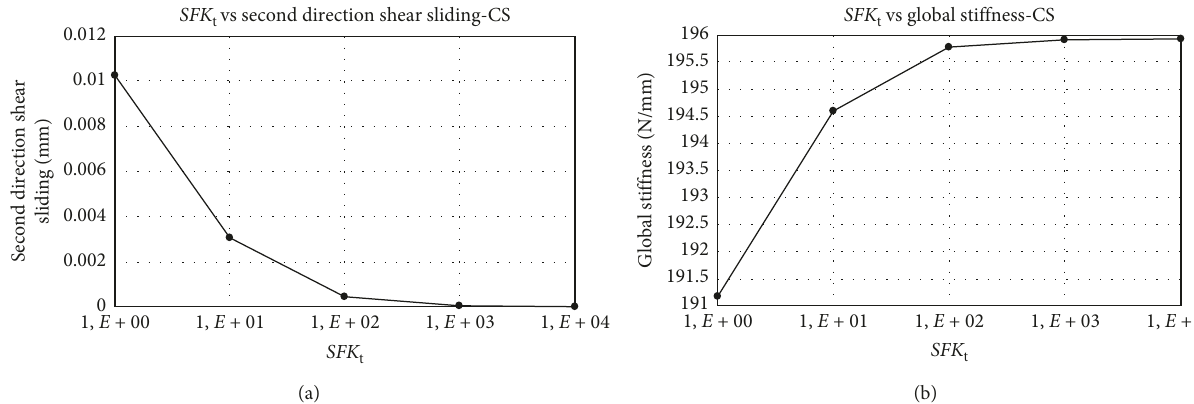
Figure 10: Sliding in first shear direction (a) and global stiffness (b) as a function of k